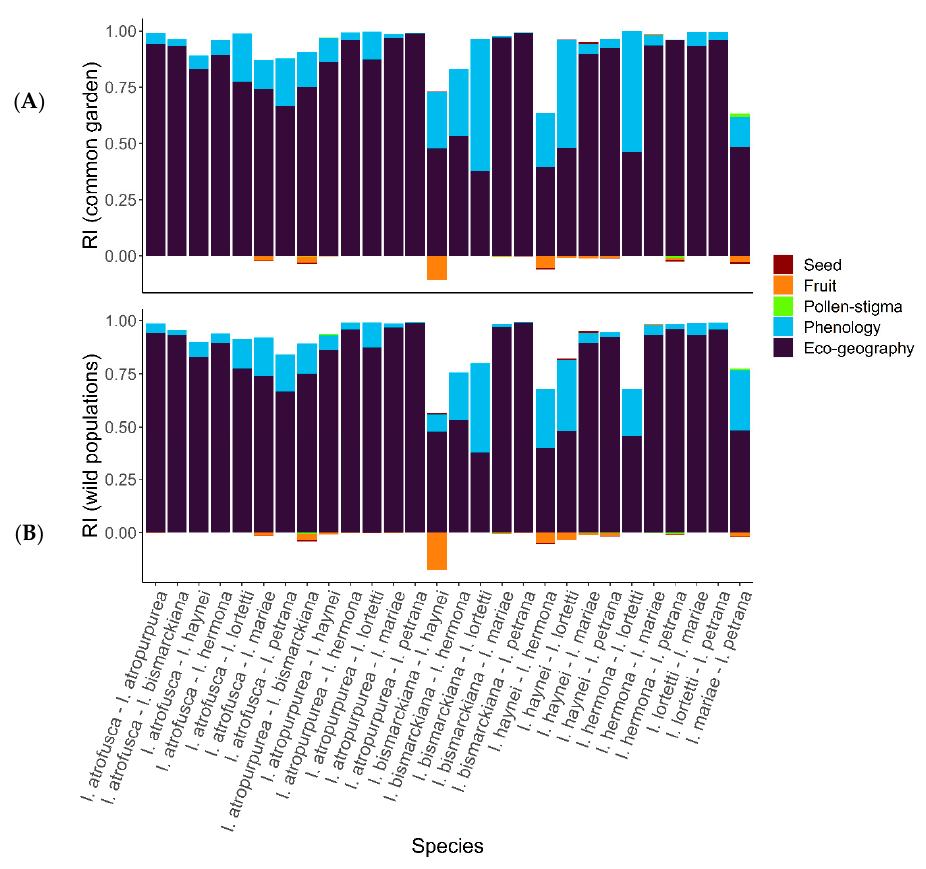
Figure 6. The relative contribution of individual reproductive barriers to total reproductive isolation (RI) between pairs of species. ( A ) RI calculated with phenology measured in a controlled environment at the net house in the Tel Aviv University Botanic Garden. ( B ) RI calculated with phenology recorded in wild populations. Table 2. Reproductive isolation (RI) values among eight Israeli Iris species. Above the diagonal—RI values calculated with phenology data from net-house (common garden); Below the diagonal—RI values calculated with phenology data from wild populations (see METHODS).